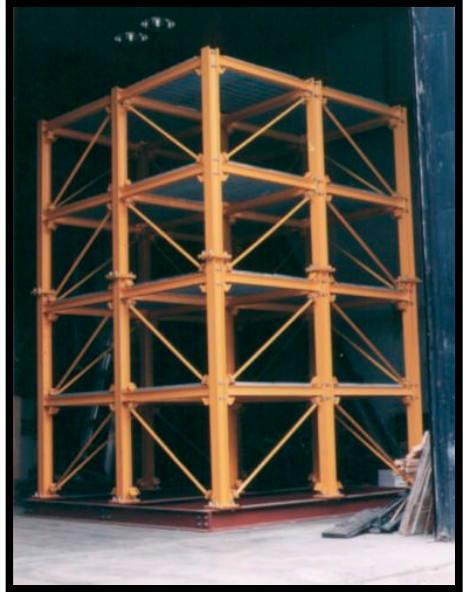
Figure 9. Model of the benchmark structure [40]. Table 2. Test scenario description [40].